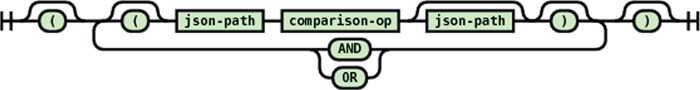
Syntax diagram for the conditional expression supported in JSONTL.